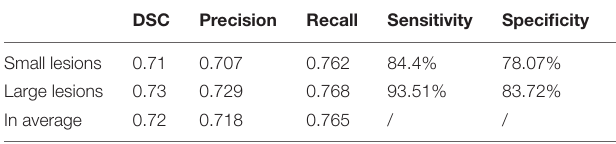
TABLE 3 | Model performance obtained from the testing dataset.